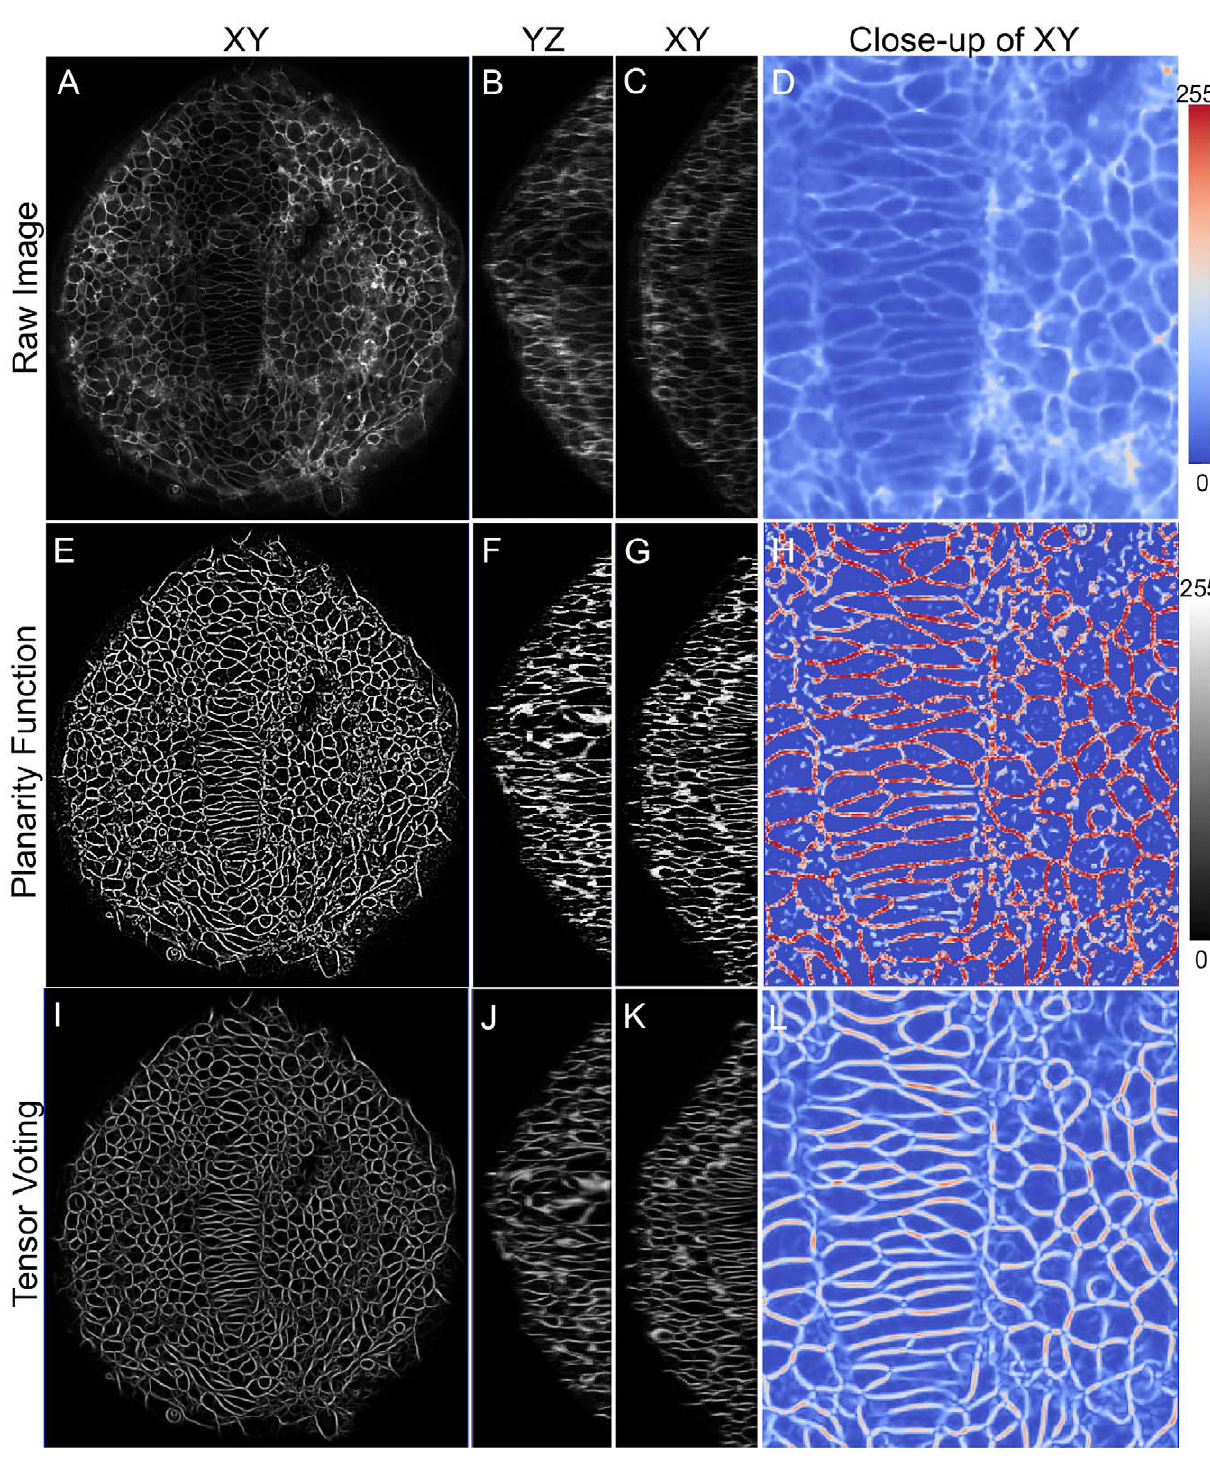
Figure 4. High-fidelity reconstruction of zebrafish membrane images. Significant improvement in membrane signal quality is shown in XY, XZ and YZ planes. (A–D) Raw data showing dorsal view (anterior on top) of zebrafish neuroepithelium (ne) and notochord at 12 hpf, (E–H) Planarity function intermediate output and (I–L) Tensor voting final output. The last image in each panel shows a color-mapped zoomed view for easy comparison. doi:10.1371/journal.pcbi.1002780.g004 There are three stages of the tensor voting process: (i) initialize a Initialize a tensor image. First, a tensor image T init is constructed to represent the affiliation to a geometric surface at tensor image, (ii) cast and accumulate votes at each voxel, and (iii) each voxel and the corresponding direction of its surface-normal. extract membrane saliency image.